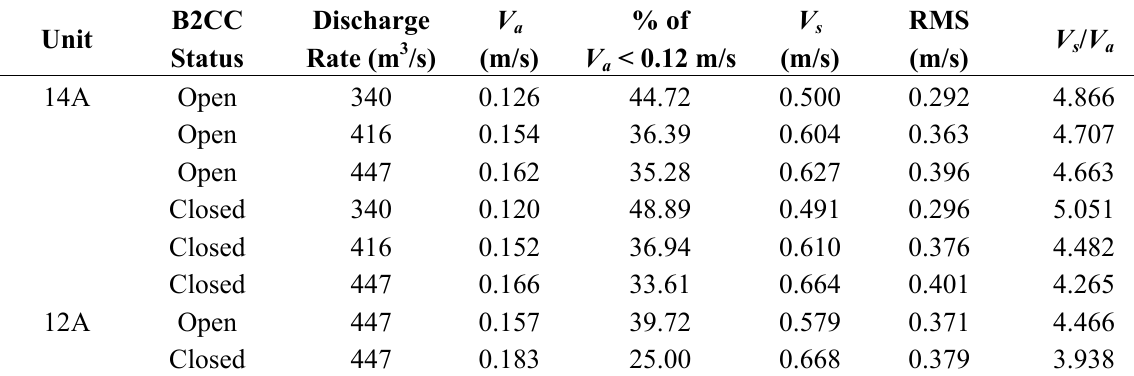
Table 1. Spatially-averaged measurement results for different discharge rates and B2CC operational statuses at units 14A and